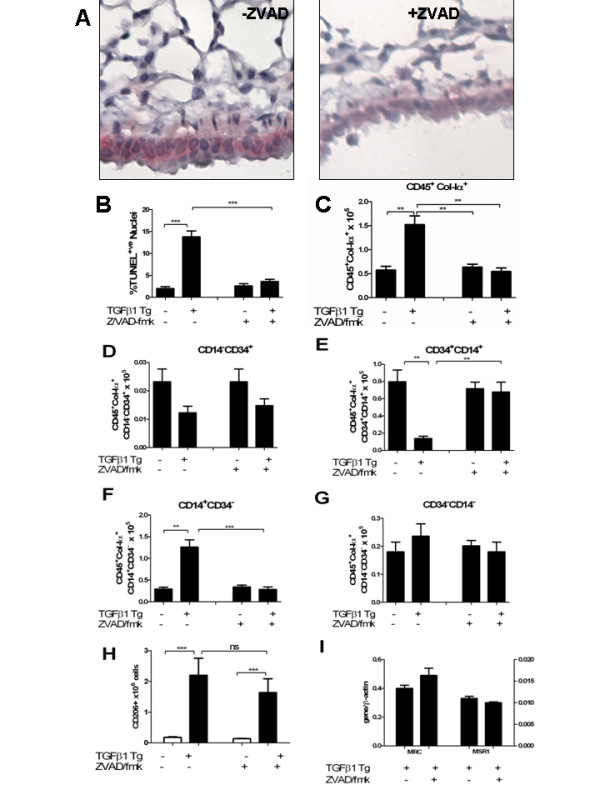
Effect of caspase inhibition of transforming growth factor (TGF)-β1-induced apoptosis and CD45+ collagen (Col)-Iα1+ cell accumulation. (a) Cleaved caspase-3 immunohistochemistry (red) in TGF-β1 Tg+ mice exposed to vehicle (left) or carbobenzoxy-valyl-alanyl-aspartyl-[O-methyl]-fluoromethylketone (Z-VAD/fmk) (right). Nuclei are counterstained with hematoxylin, 40 × original magnification. A significant reduction in cleaved (activated) caspase-3 is noted in the Z-VAD/fmk treated mice. (b,c) Z-VAD/fmk reduces terminal deoxynucleotidyl transferase dUTP nick end labeling (TUNEL) staining (b) and CD45+Col-Iα1+ cells (c) in TGF-β1 Tg+ mice. (d-f) Compared to untreated mice, the lungs of TGF-β1 Tg+ treated with Z-VAD/ fmk demonstrate unchanged quantities of CD45+Col-Iα1+CD14-CD34+ cells (d), increased quantities of CD45+Col-Iα1+CD14+CD34+cells (e), reduced quantities of CD45+Col-Iα1+CD14+CD34- cells, and unchanged quantities of CD45+Col-Iα1+CD14-CD34- cells. (h) Accumulation of CD206/MRC+ cells is not affected by Z-VAD/fmk. (i) TGF-β1-induced expression of the scavenger receptors MRC (left axis) and MSR-1 (right axis) is not affected by administration of Z-VAD/fmk. N = 5 mice/group. *P < 0.05, **P < 0.01, ***P < 0.001.